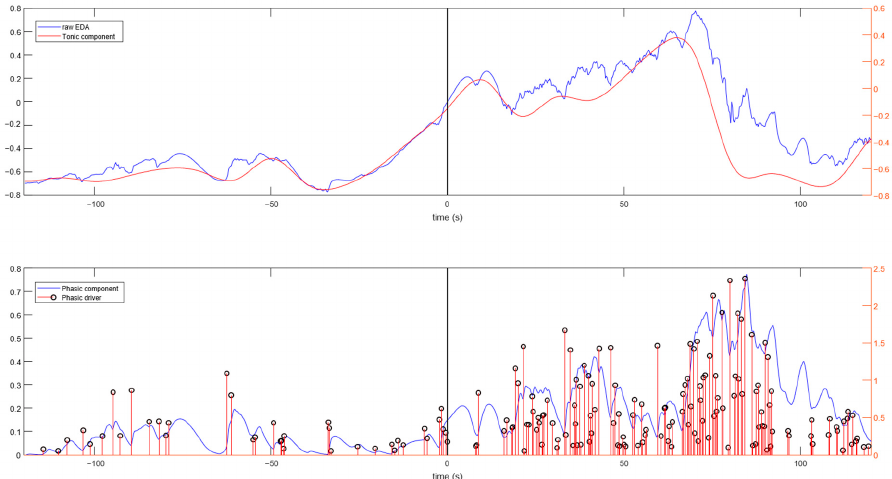
Figure 4. Raw EDA signal and tonic component ( top ), and phasic component and phasic drivers that are greater than 0.05 µS ( bottom ) before (baseline) and during the Feeding test for a sample subject.